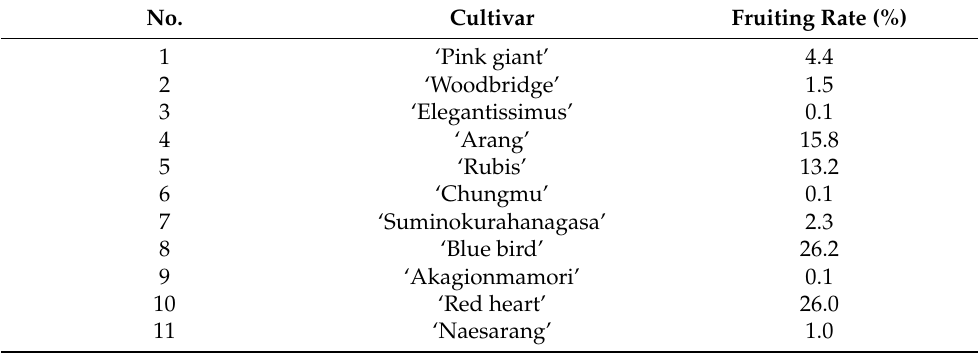
Table A2. The fruiting rates of 11 Hibiscus syriacus